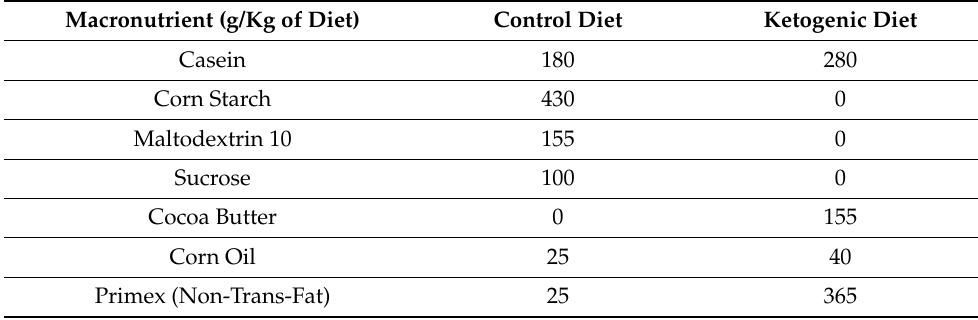
Table 1. Macronutrients in the experimental diets. Macronutrient (g/Kg of Diet) Control Diet Ketogenic Diet